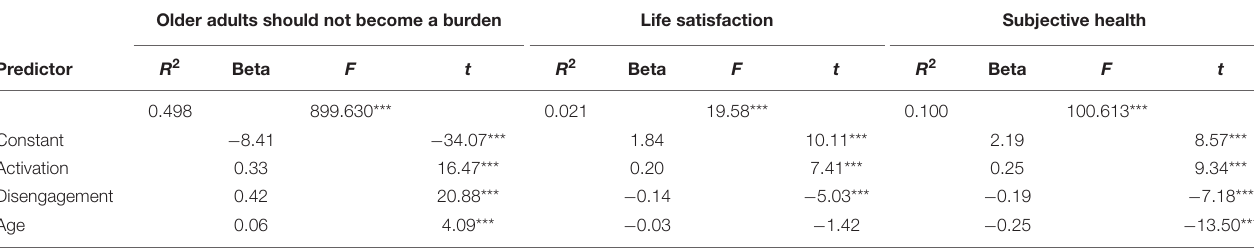
TABLE 5 | Multiple regression analysis predicting the expectation that older adults should not become a burden, life satisfaction, and subjective health from activation, disengagement, and age ( N = 2724). Older adults should not become a burden Life